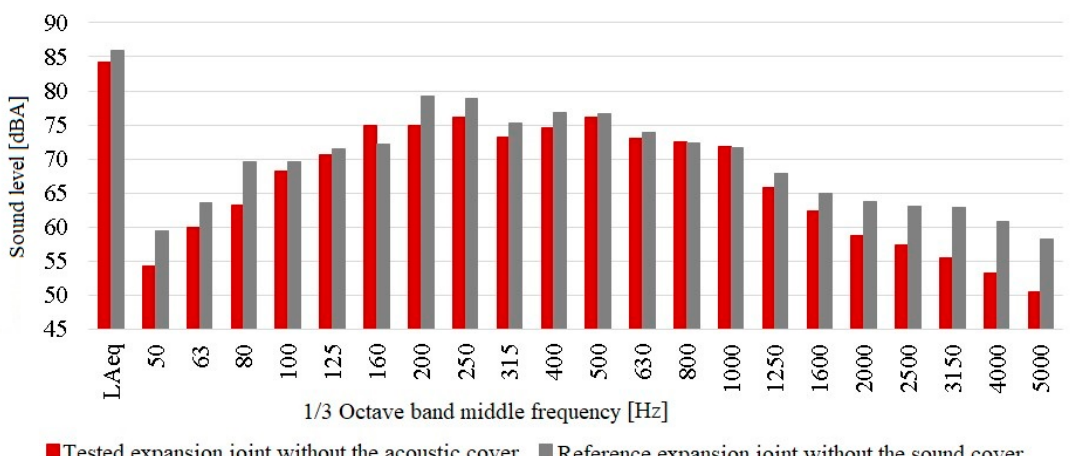
Figure 12. Results of the acoustic measurements at points located under the tested expansion joint without the acoustic cover, and under the reference expansion joint.